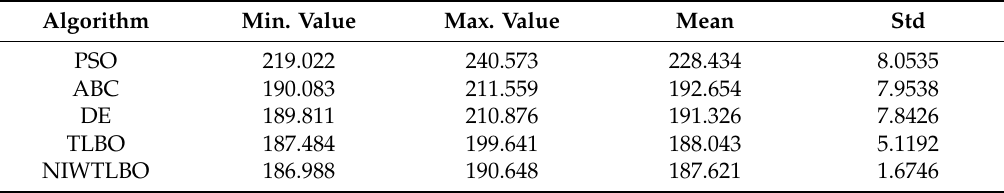
Table 1. Comparative results of path